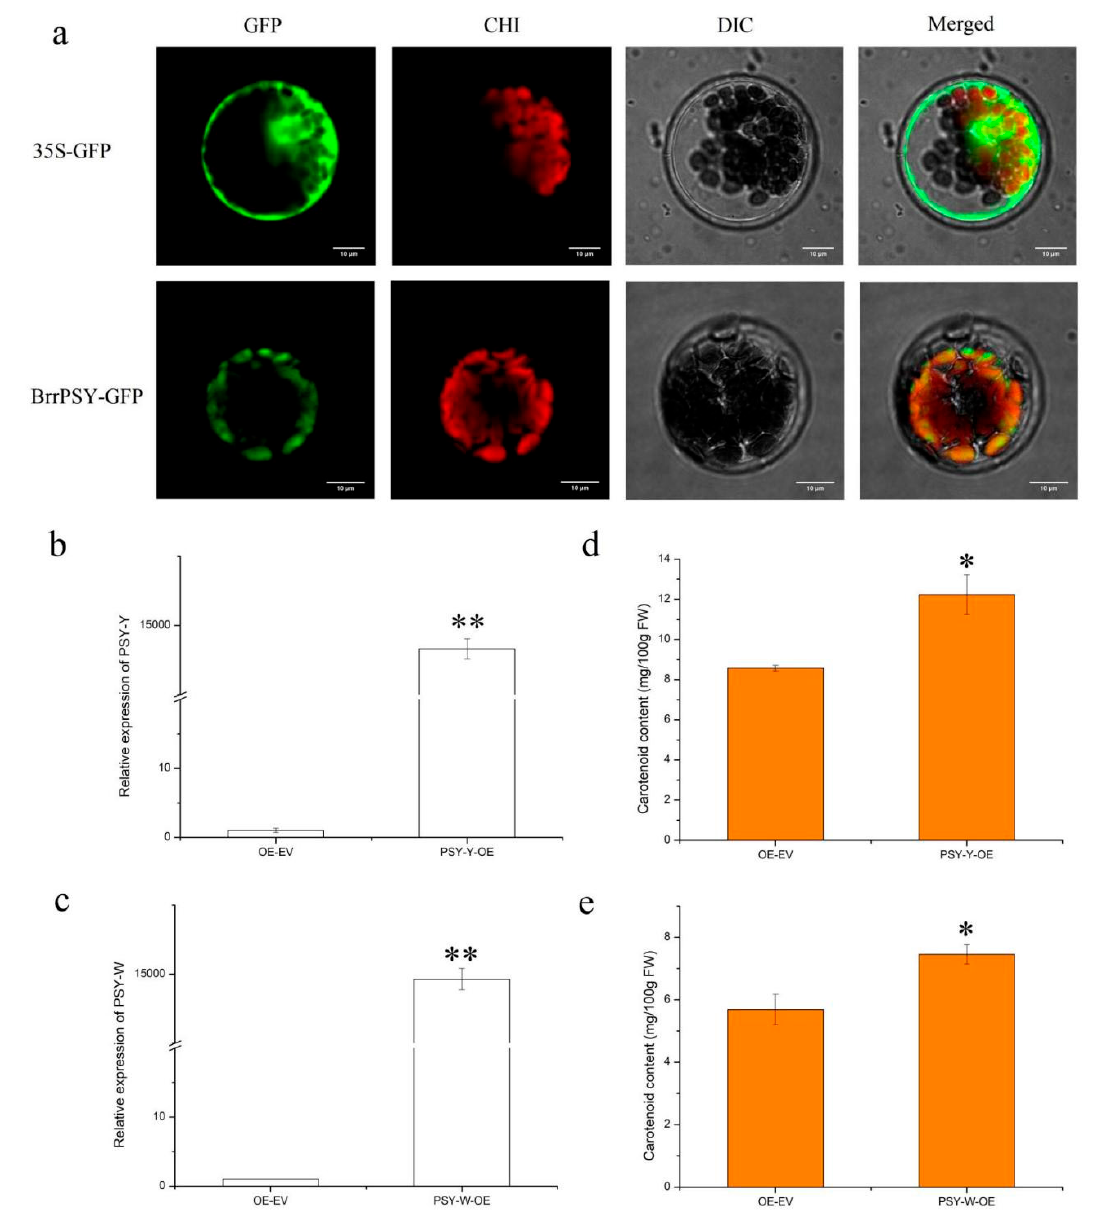
Figure 7. Subcellular localization and functional analysis of BrrPSY gene. ( a ) The subcellular localization of BrrPSY protein. ( b , c ) The relative expression levels of PSY-Y and PSY-W genes in the over-expressing tobacco leaves and control. ( d , e ) The carotenoid contents in the over-expressing tobacco leaves and control. * indicates a significant difference when p < 0.05, ** indicates a significant difference when p < 0.01.